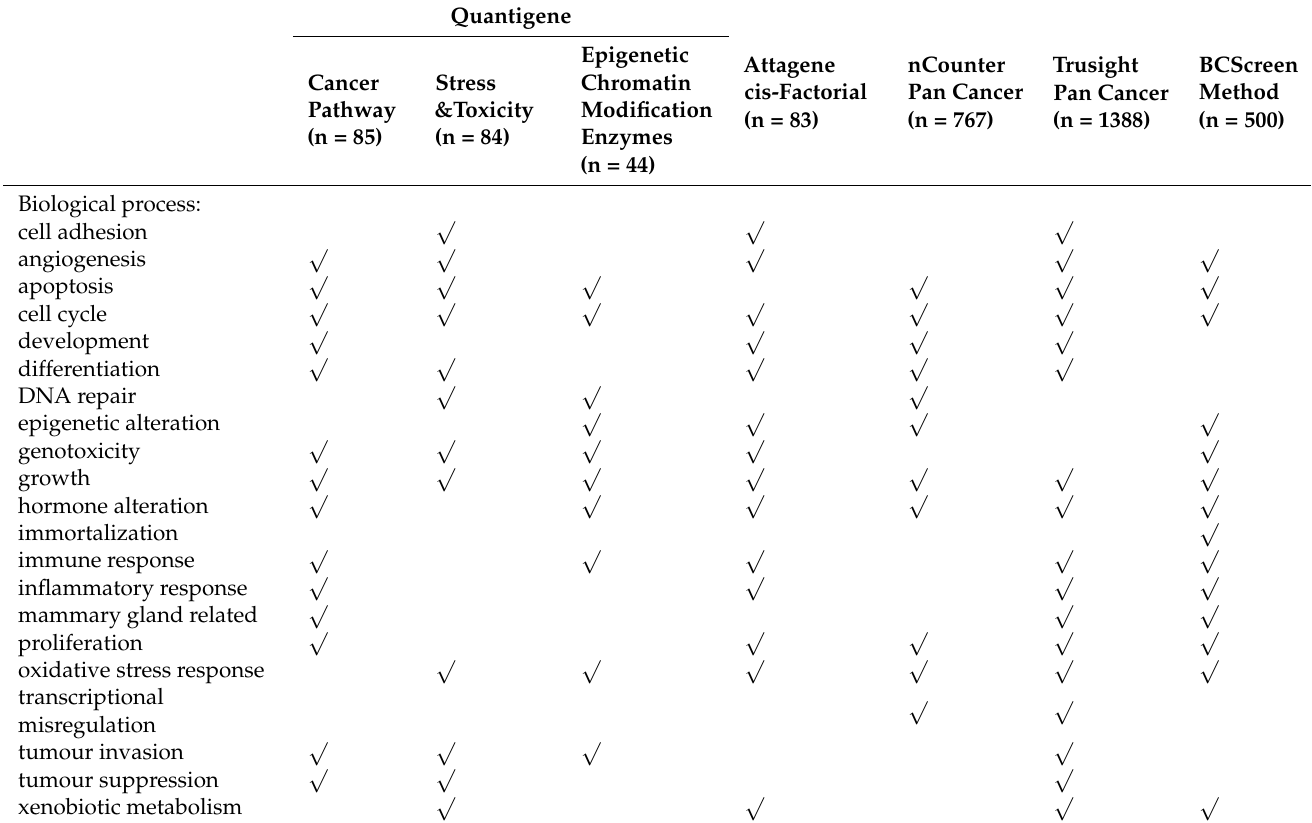
Table 1. Comparison of the biological processes addressed by selected transcriptional assays and gene panels. Quantigene